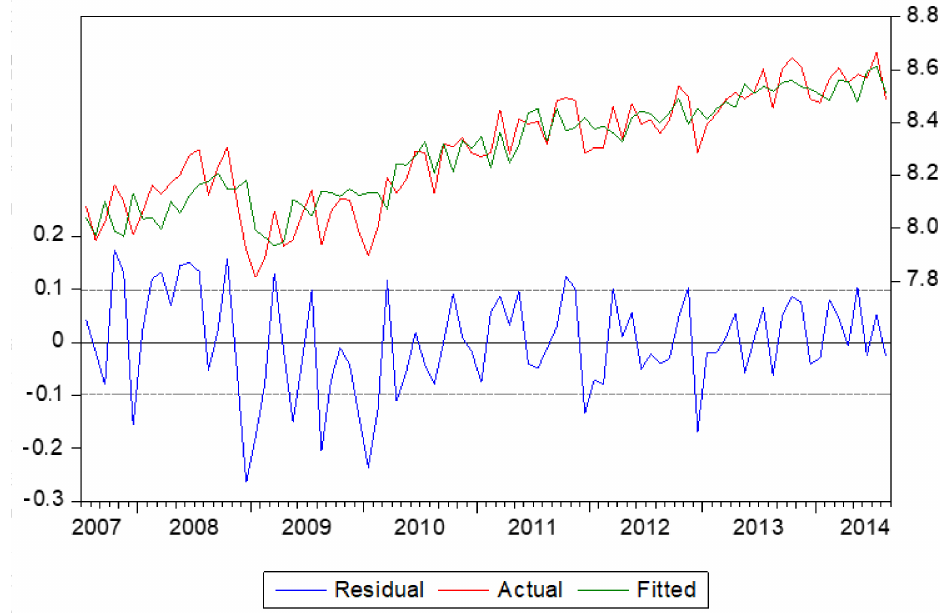
Figure 2. Actual, fitted and residuals of exports’